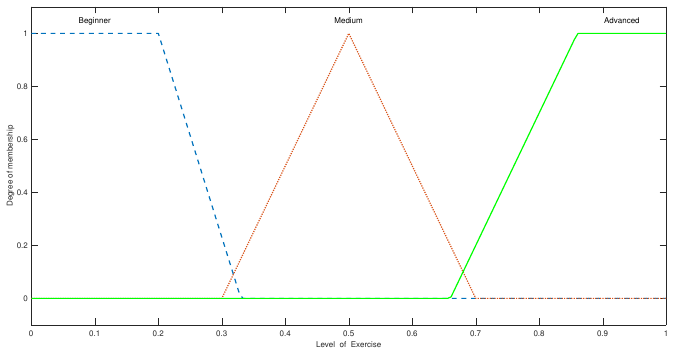
Figure 4. The membership function plot for level of exercise